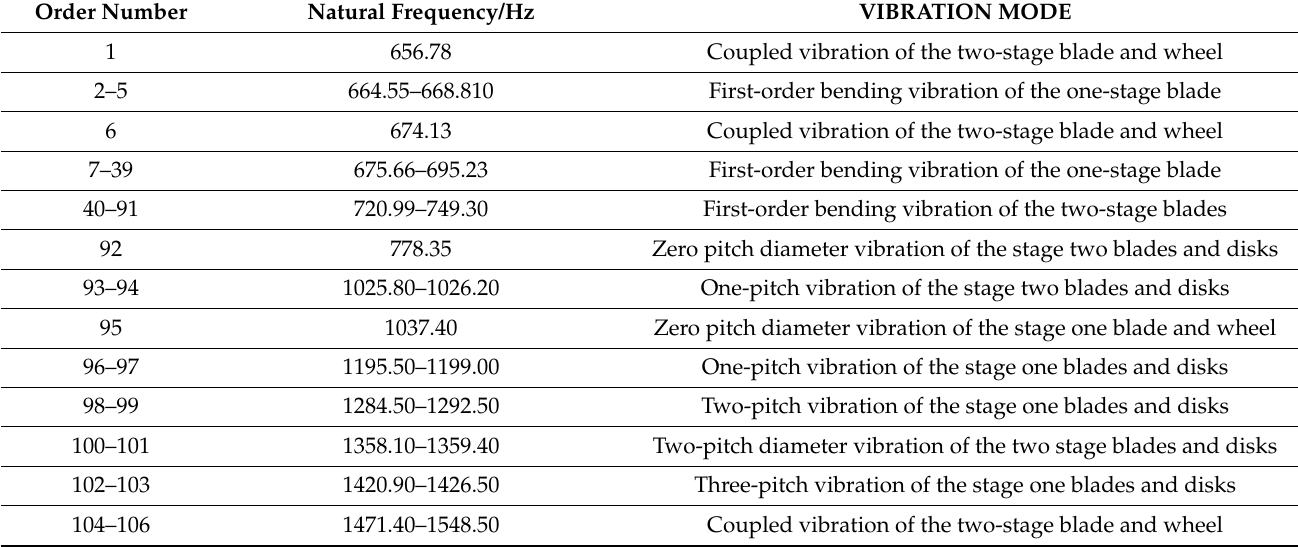
Table 9. First 160th order natural frequencies and mode shapes of the two-stage bladed disk coupled